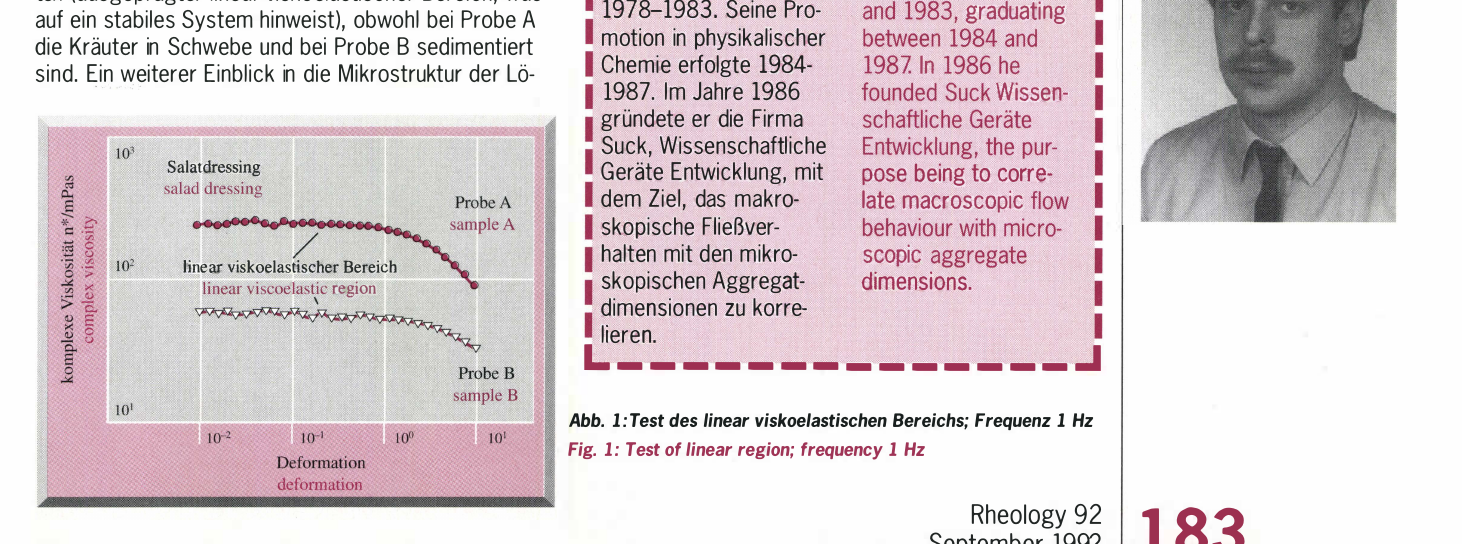
Fig. 1: Test of linear region; frequency 1